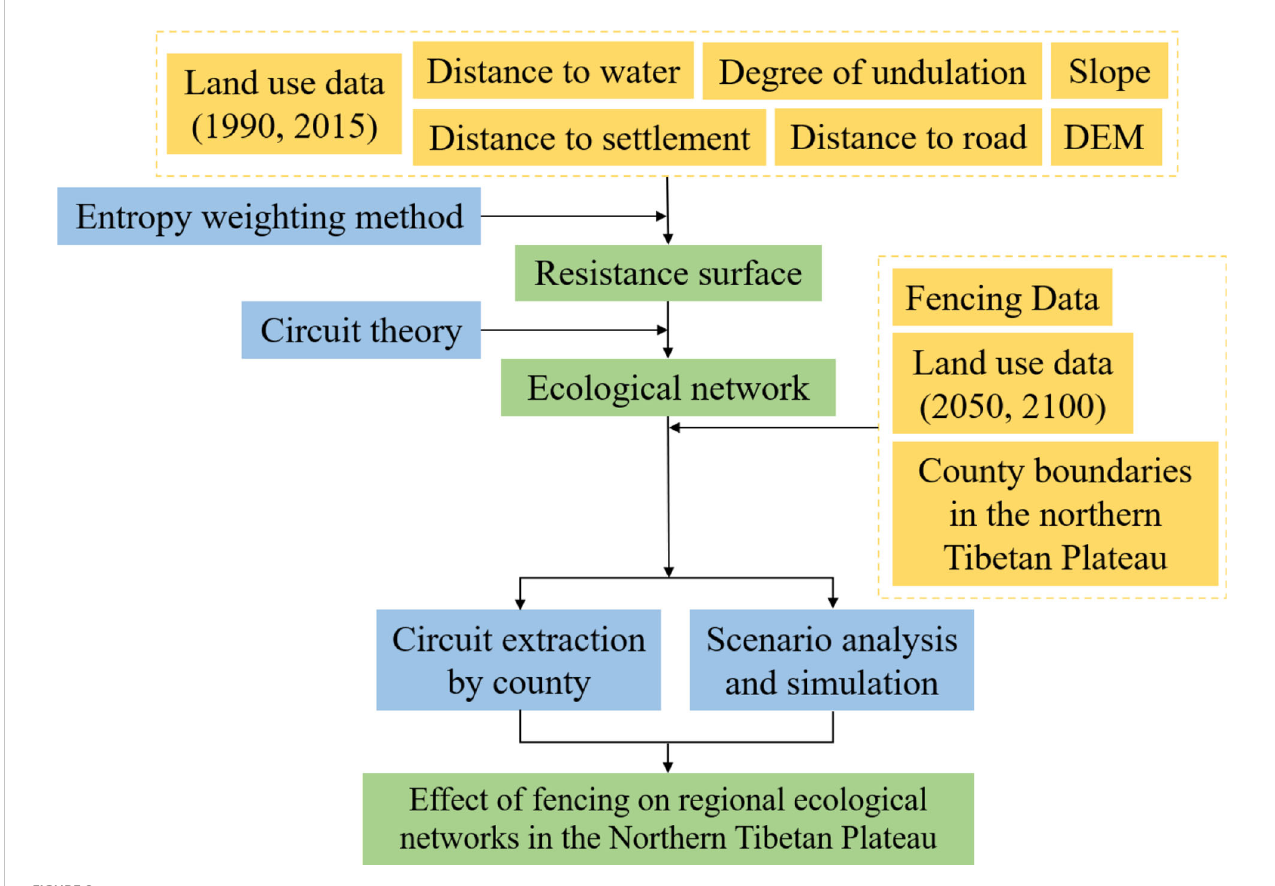
FIGURE 2 The working fl owchart of this